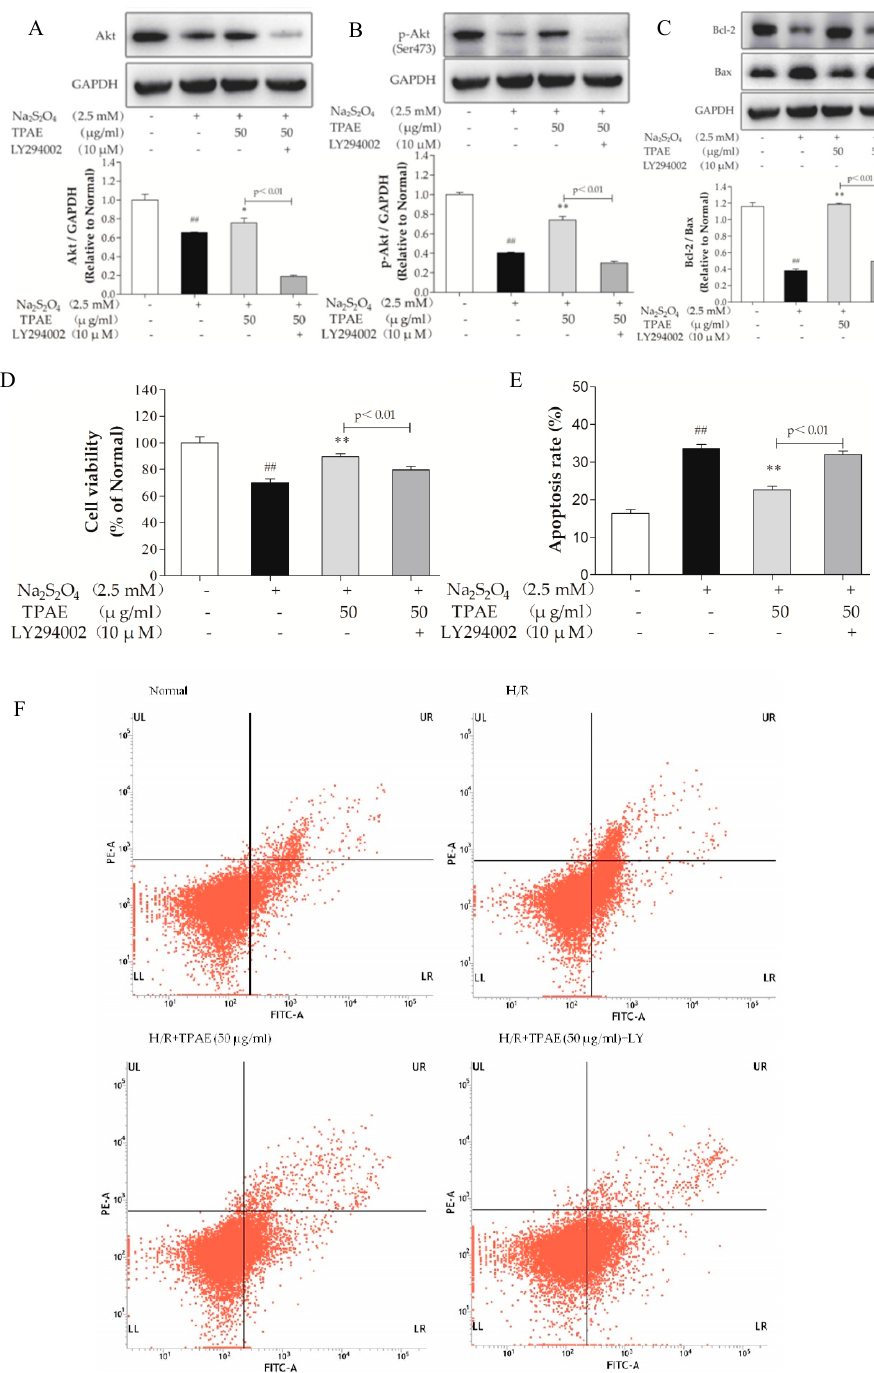
Figure 4. Inhibiting the PI3K/Akt pathway alleviated the cardioprotection of TPAE. H9c2 cells were incubated with 10 µ M LY294002 co-treated TPAE (50 µ g/mL) for 24 h followed by H/R. The protein expression of Akt ( A ), p-Akt (Ser473) ( B ), Bax ( C ), Bcl-2 ( C ) and GAPDH was measured by western blotting. Quantitative analyses of Akt normalized to GAPDH ( A ), p-Akt (Ser473) normalized to GAPDH (B), the ratio of Bcl-2 to Bax ( C ) in protein expression were evaluated; ( D ) Cell viability was evaluated by MTT assay; ( E ) The apoptosis rate was quantified by BD FACSVerse software; ( F ) The apoptotic ratio of H9c2 cells was measured by flow cytometry using Annexin V-FITC and PI staining. Values were represented as mean ± SD (n = 3 for western blot, n = 6 for MTT, each group). The results were representative of three independent experiments. # p < 0.05, ## p < 0.05 vs. normal group; * p < 0.05, ** p < 0.01 vs. H/R